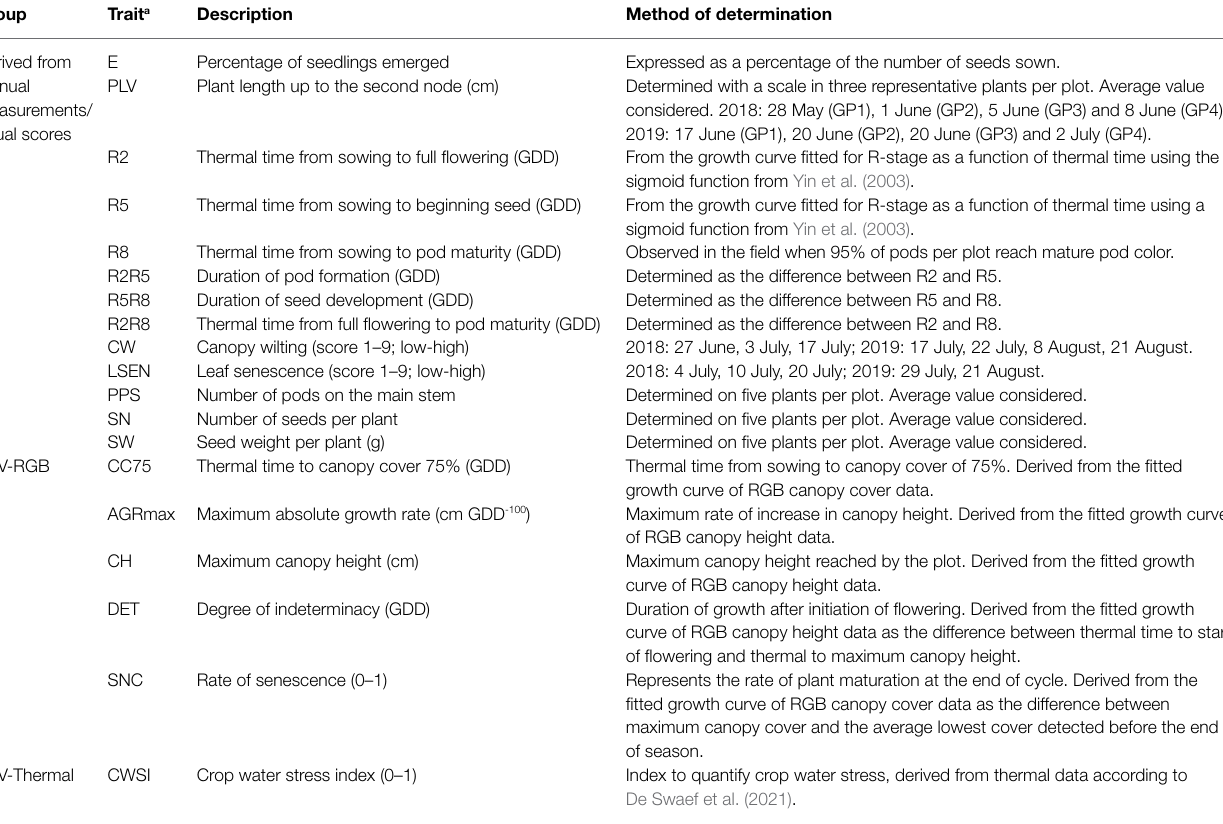
TABLE 1 | Description of the traits determined in 2018 and